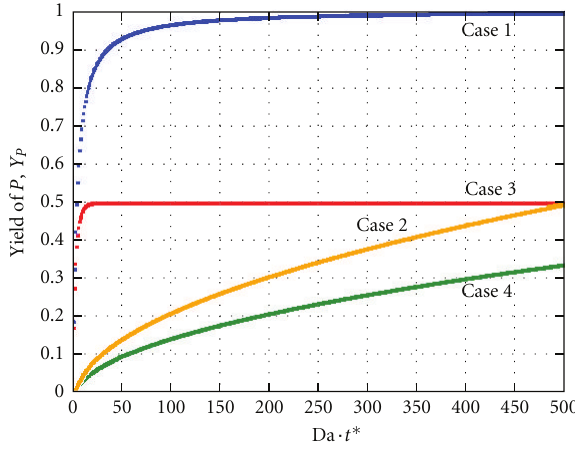
Figure 5: Yield of P versus time for the C-P